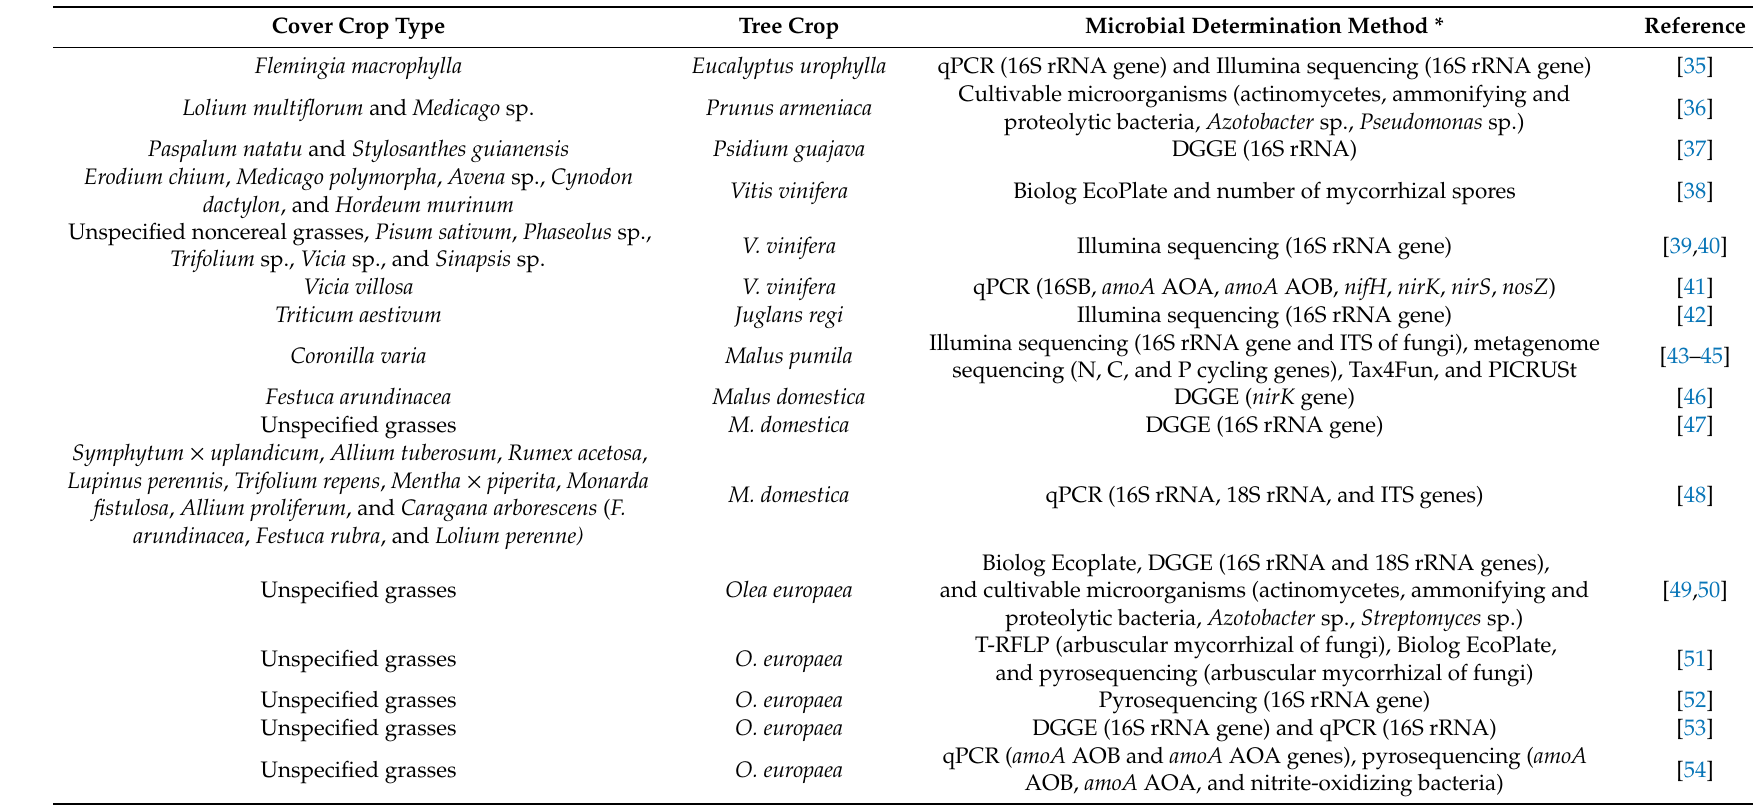
Table 1. Summary of studies comparing the e ff ect of cover crop treatments on soil microbial communities in woody perennial